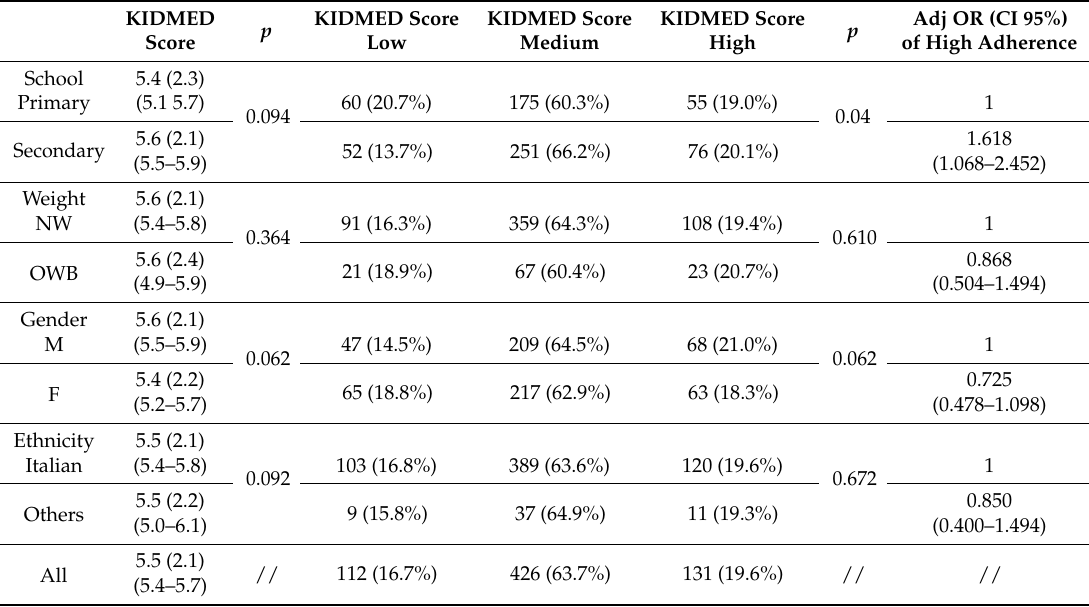
Table 2. Distribution of the adherence to the MD of the study population and relative odd ratios among